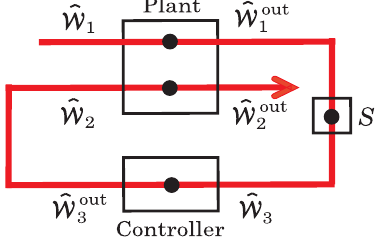
FIG. 9. General configuration of the type-2 CF